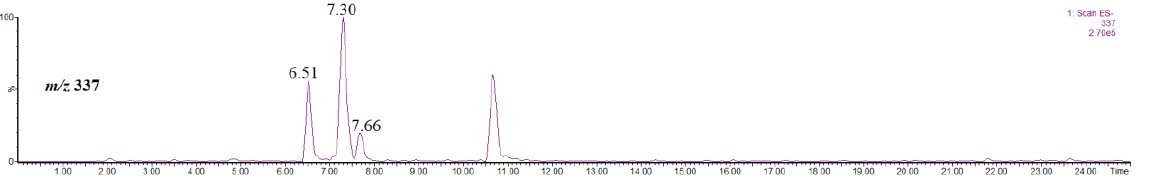
Figure 5. Single ion chromatogram of the ion at m/z 337, thus the [M-H] − ion of coumaroylquinic acid isomers.